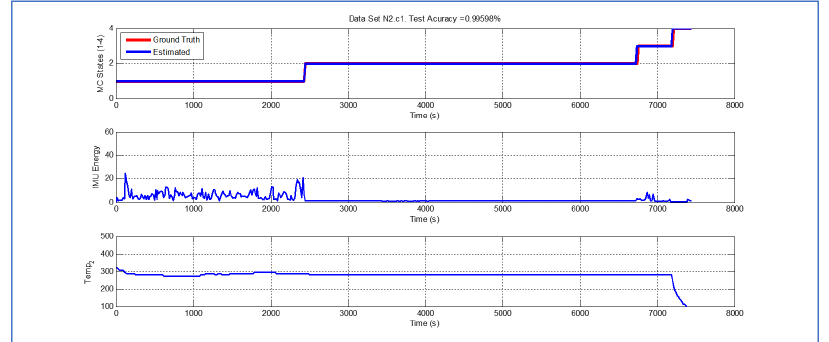
Figure 5. Detection of berry harvesting stages. Dataset N 2 c 1